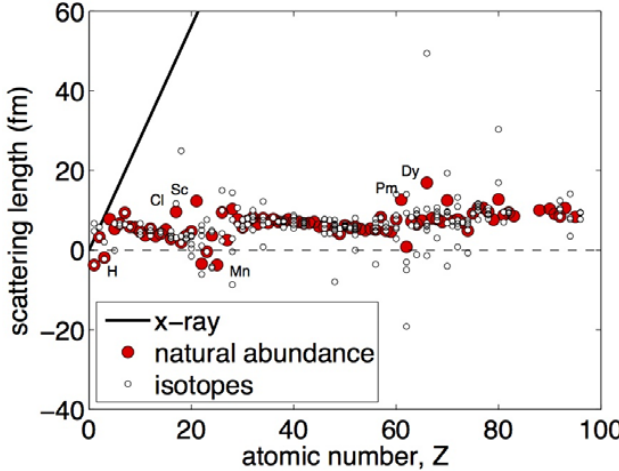
Figure 3. Neutron coherent scattering length, b i , as a function of atomic number, Z . The X-ray scattering length is computed using Equation (6).